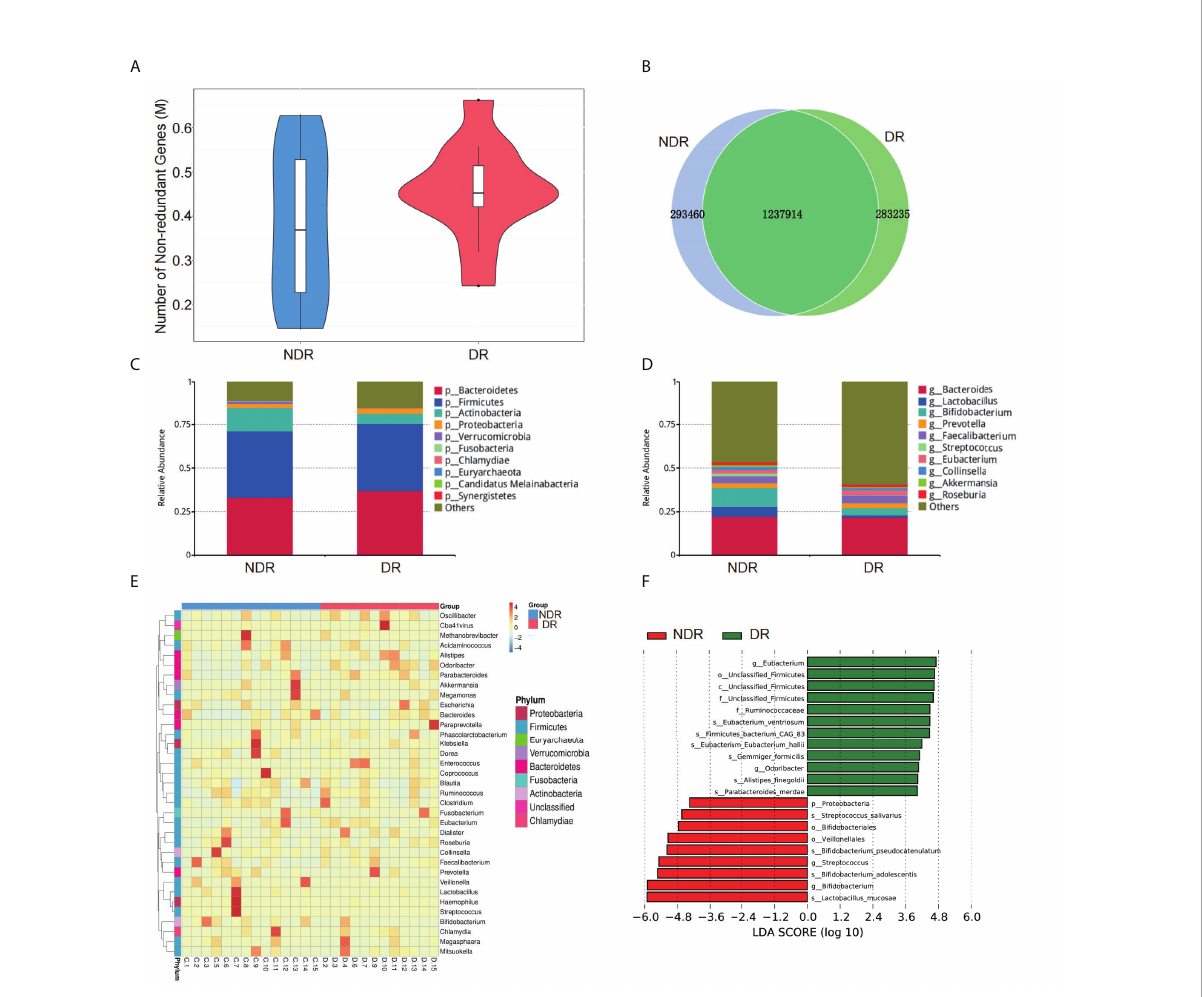
FIGURE 2 Characterization of the gut microbiome from metagenomic data. (A) The number of nonredundant genes in the DR and NDR groups. (B) The identi fi cation of genes in the DR and NDR groups. (C) Top 10 microbiome phyla between the case and control groups. (D) Top 10 microbiome from the genera of case and control groups. (E) Heat map showing the levels of microbiome from each participant. (F) The in fl uence of differentially expressed microbiome using LDA. DR, diabetic retinopathy; NDR, diabetes without diabetic retinopathy; LDA, linear